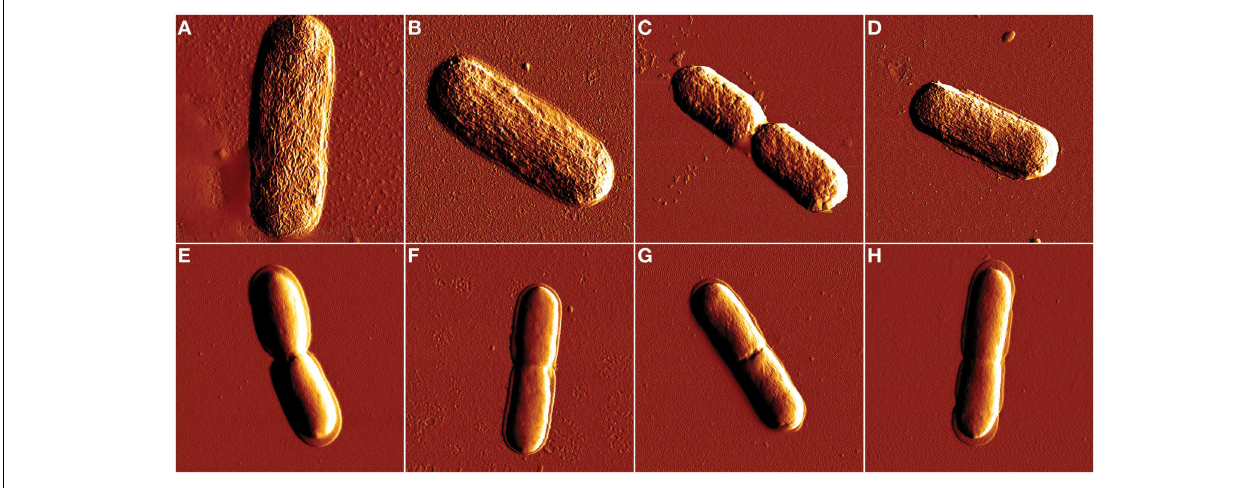
isoeugenol at 0 (A,E) , ½ × MIC (B,F) , MIC (C,G) , or 2 × MIC (D,H) in MES-buffer (pH = 6.0) at 25 ◦ C for an hour. Images of E. coli and L. innocua were 4 × 4 and 3 × 3 µ m, respectively.